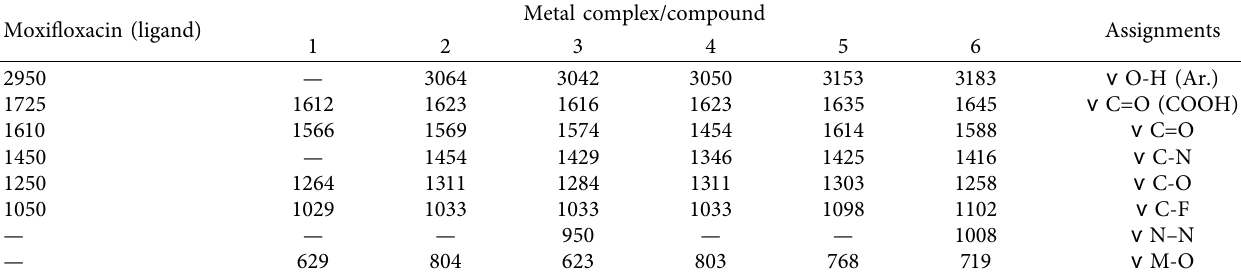
Table 3: Te FT-IR analysis of moxifoxacin and its new metal complexes (1–6). Moxifoxacin (ligand)